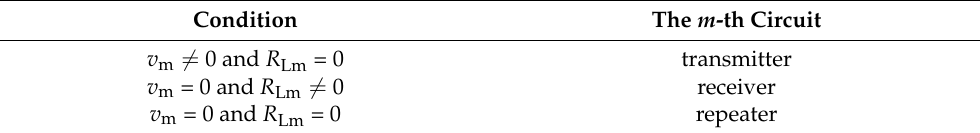
Table 1. The role of